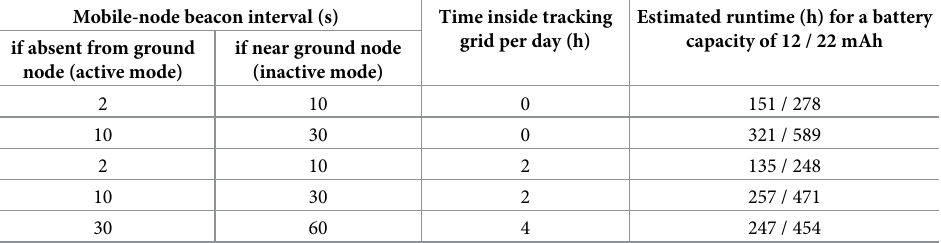
Table 1. Estimated runtimes of mobile nodes for 2 battery capacities of 12 or 22 mAh inferred by an energy model for mobile-node runtime. Although the model comprises 7 energy consuming tasks, the shown runtimes are based only on varying beacon intervals of mobile nodes and localization time (i.e., animal is within the localization grid). For mobile node beacon intervals, 2 operation modes are possible, depending on whether an animal is within reception range of a ground node (inactive mode) or not (active